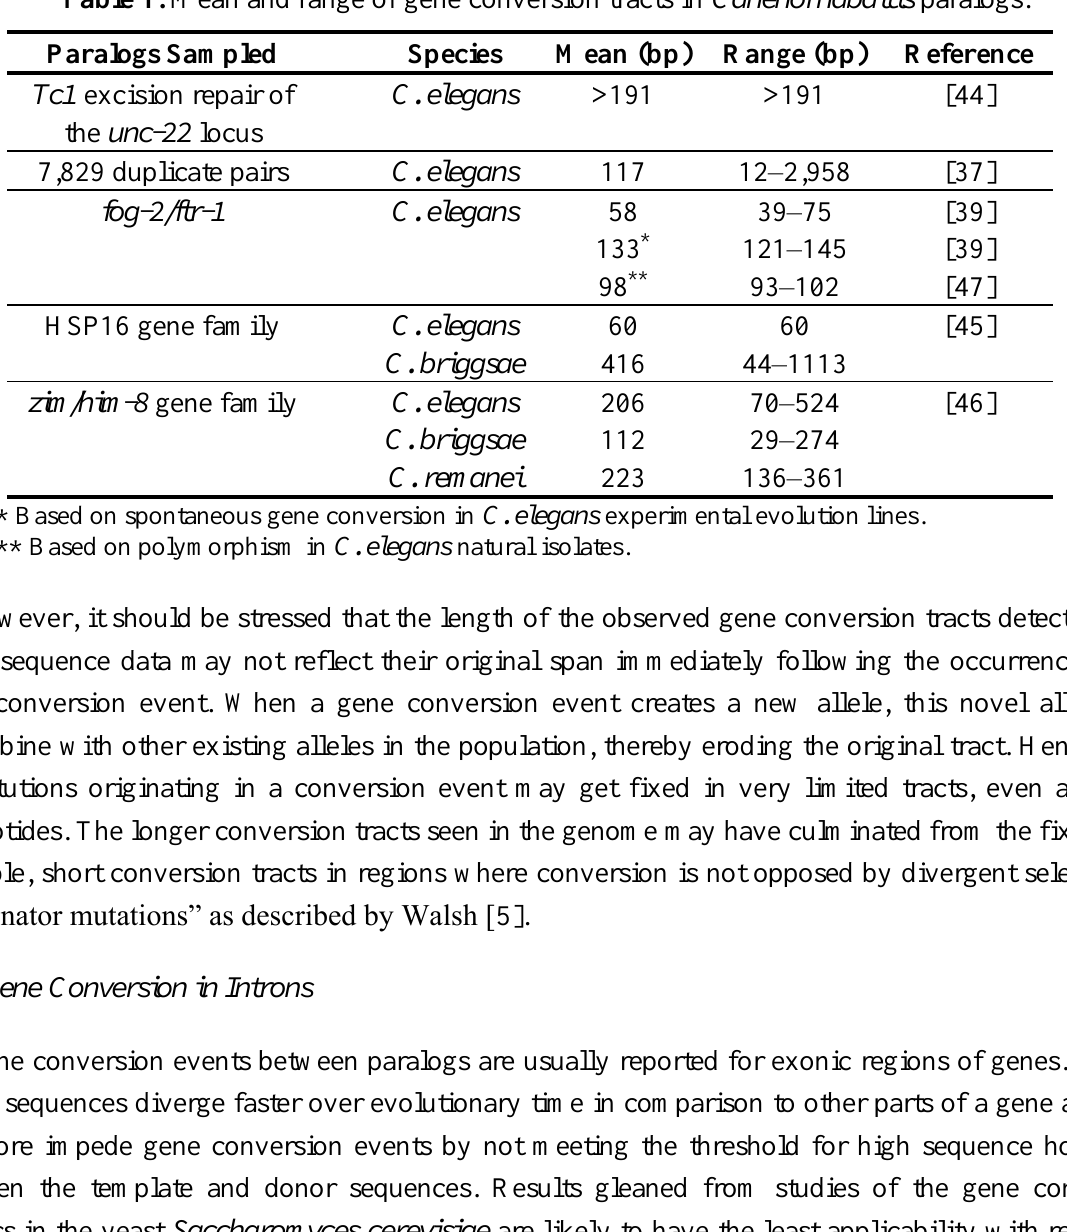
Table 1. Mean and range of gene conversion tracts in Canenorhabditis